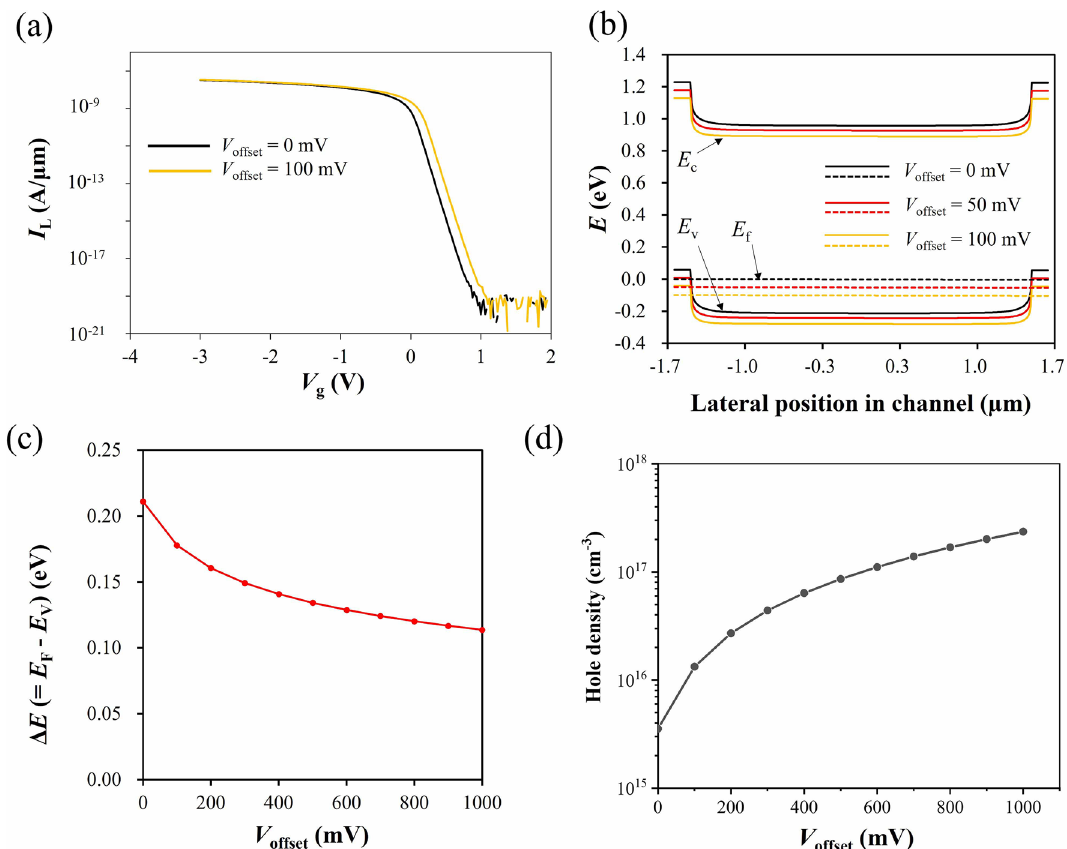
Figure 3. Simulation results. ( a ) Current at reservoir L, I L of the device shown in Fig. 2 as a function of V g when V offset = 0 mV (black) or 100 mV (orange). At V offset = 100 mV, the threshold voltage of the device shifts slightly in the positive direction. ( b ) Simulated energy band diagrams on the surface of Si channel in MOS structure model at 300 K. V g = 0 V (threshold region), V bias = 4 mV, and V offset = 0 mV (black), 50 mV (red), and 100 mV (orange). All the valence band edge ( E V ), the conduction band edge ( E C ), and the Fermi level ( E F ) shift depending on V offset . ( c ) The reservoir offset voltage dependence of the difference between E F and E V ( (cid:31) E ) at V g = 0 V and V bias = 4 mV when the range of V offset expanded to hundreds of millivolts. Since (cid:31) E corresponds to the hole concentration induced in the Si layer, the reservoir offset voltage has a function to tune the number of induced holes in the reservoirs. ( d ) A simulated hole density on the top of the Si channel depending on the reservoir offset voltage V offset at V g = 0 V and 300